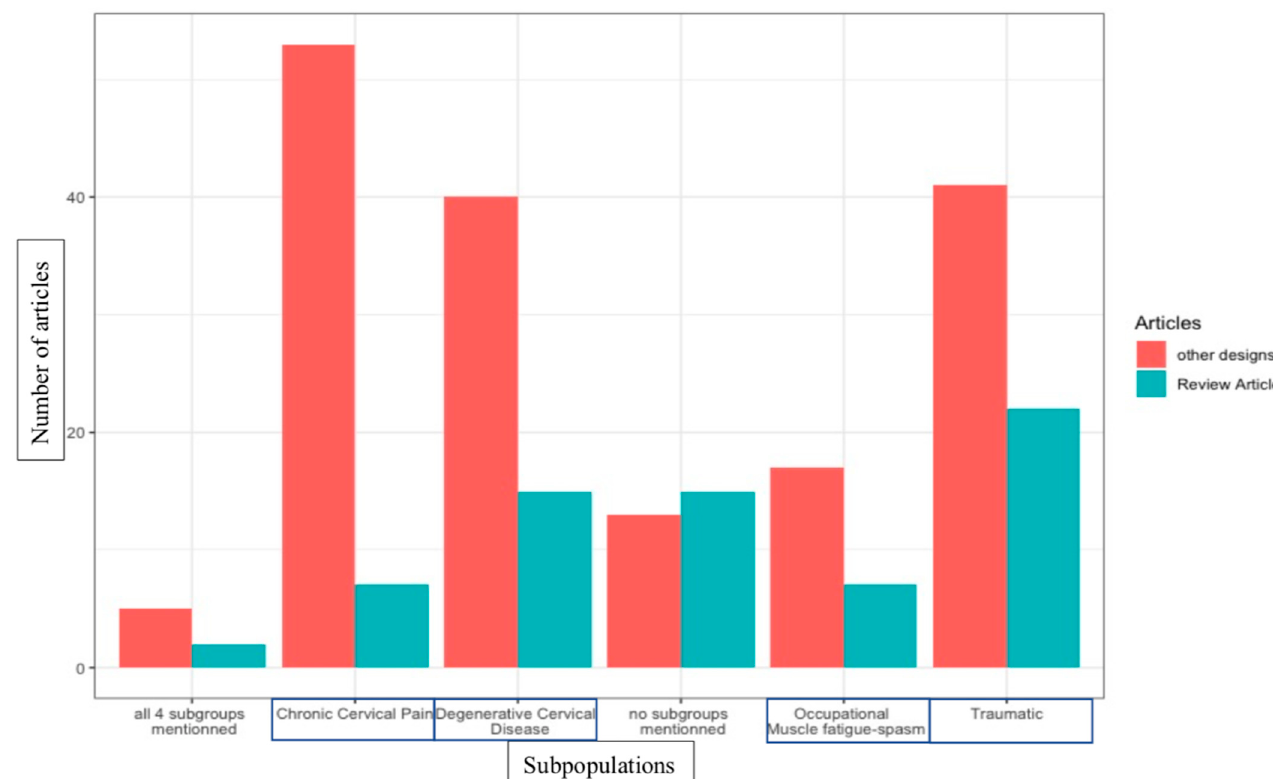
Figure 3. Quantitative synthesis of PCGD subpopulations’ occurrence in the literature. Articles